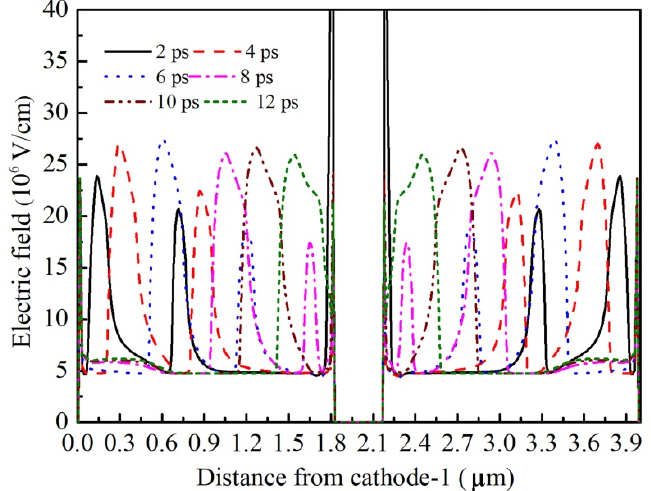
Figure 8. The electric field profiles in one oscillation period in the grooved-anode diode as L = 1.8 µm.